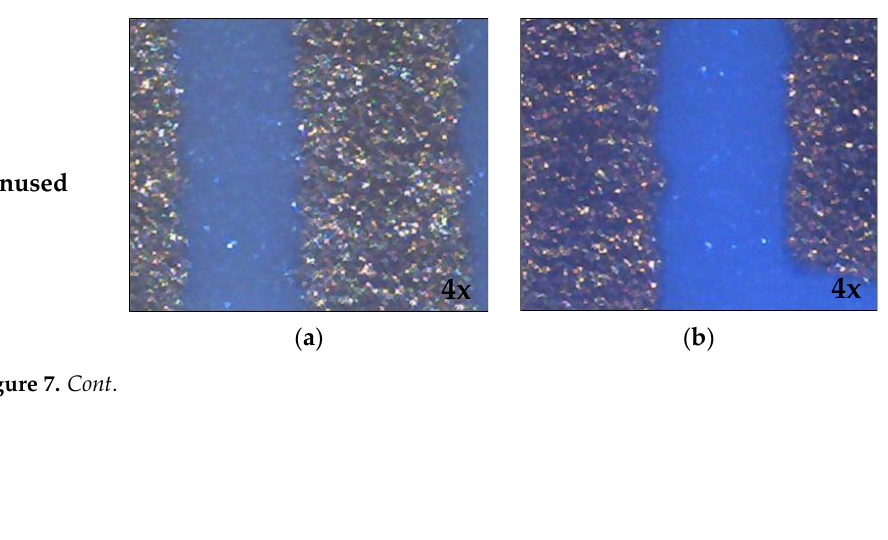
( f ) Figure 7. Optical microscopy images of the IDE sensors showing the damage caused by the increas- ingly higher values of the voltage applied during the impedance measurements. ( a ) Uncoated IDE before applying voltage, ( b ) IDE coated with (PEI/PSS) 5 film before applying voltage, ( c ) uncoated IDE after applying voltage while immersed in MW, ( d ) IDE coated with (PEI/PSS) 5 film after apply- ing voltage while immersed in MW, ( e ) uncoated IDE after applying voltage while immersed in TW, ( f ) IDE coated with (PEI/PSS) 5 film after applying voltage while immersed in TW. The images captured during the optical microscopy analysis, presented in Figure 7, give an immediate and quite evident visual confirmation of the impact that increasing AC voltages applied to each sensor have during the impedance measurements. 4. Discussion Figure 8 includes the PCA graphs calculated and plotted to give a more detailed anal- ysis of the phenomenon observed in Figure 3, and also to demonstrate how the data con- taining all the information regarding each sensor and type of water would translate into a visual representation. The principal component analysis plots, present in Figure 8, allow for an in-depth analysis of how both types of IDE sensors respond to the different waters used in this study. In Figure 8a, a plot of PC1 as a function of PC2 was plotted with all the electrical data collected during these measurements for both sensors, uncoated and with a (PEI/PSS) 5 film, in the two waters, MW and TW. From this graph, it can be perceived that Principal Component 1 is a strong tool when it comes to separating and distinguishing